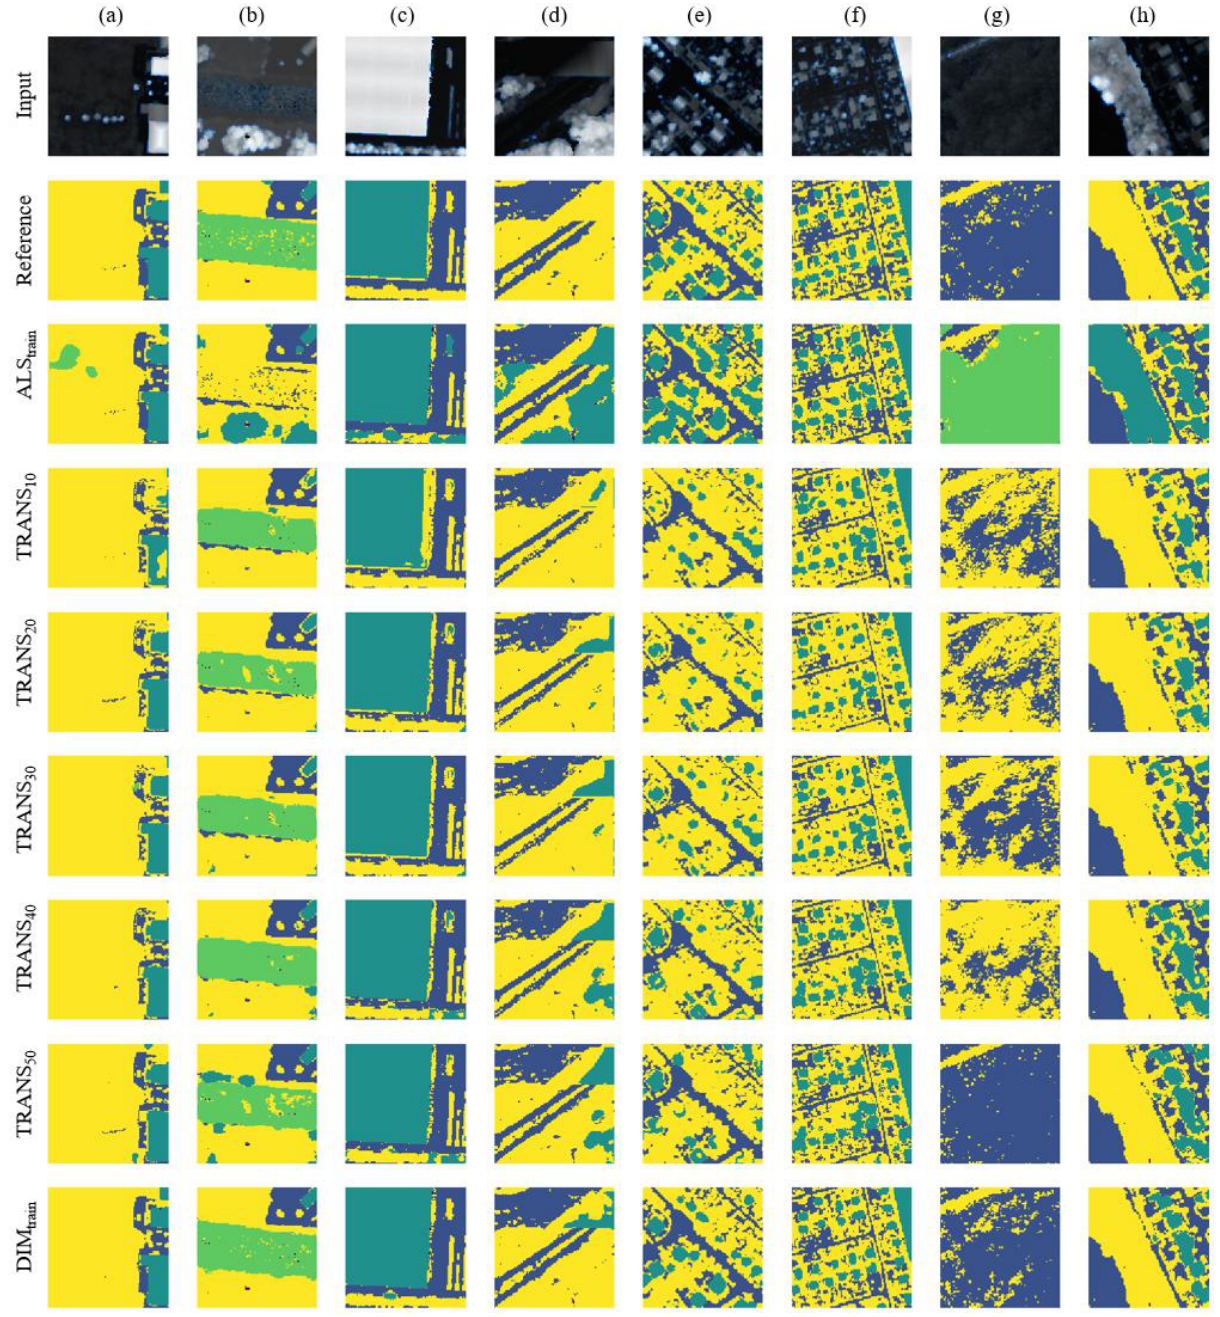
Figure 3. Qualitative results of the trained network setups in comparison for DIM test data. The input height images are rendered as normalized RGB image. The printed classes are ground (dark blue), building (petrol), water (light green) and non-ground (yellow),